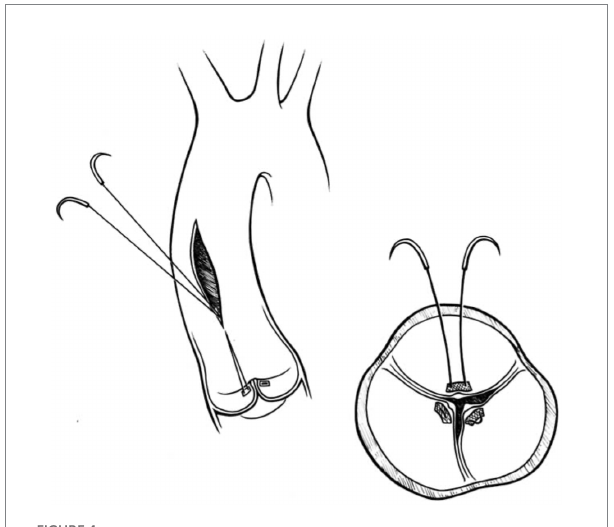
FIGURE 4 Park’s stitch. Pledgeted 4-0 Prolene sutures are applied to approximate the fibrous nodules of Arantius to create a coaptation stitch. Reproduced with permission from